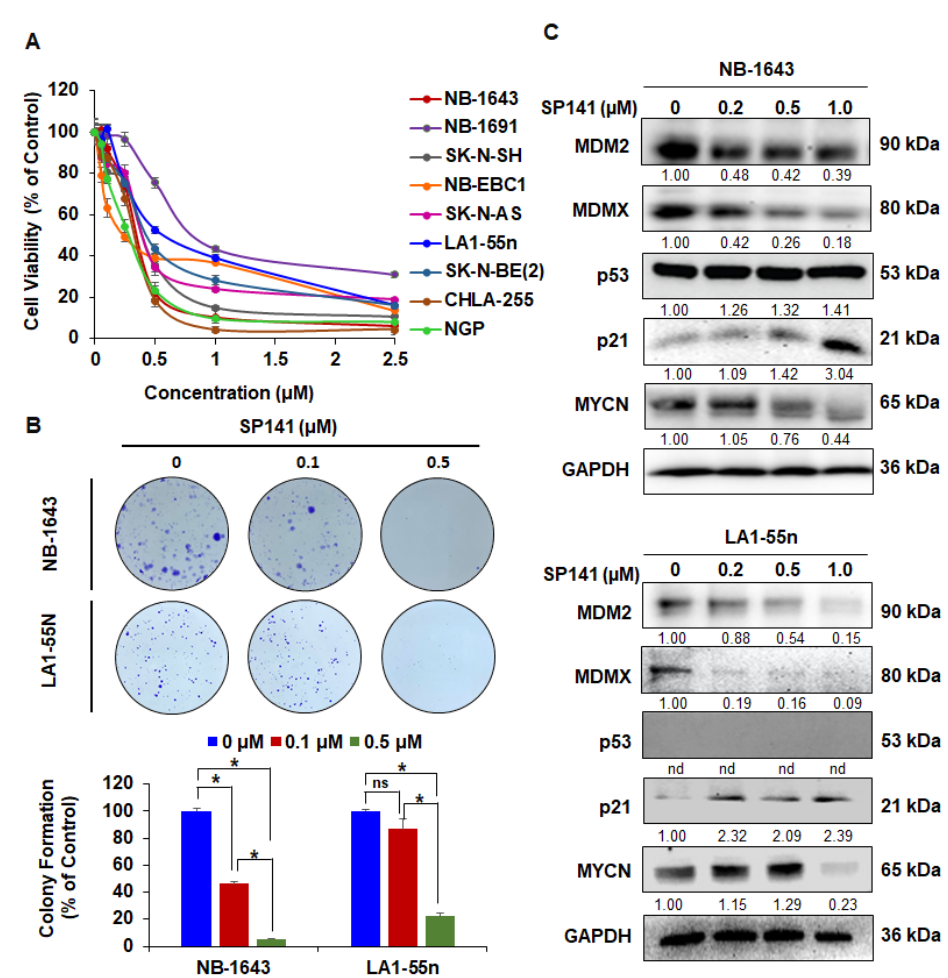
Figure 1. SP141 inhibits cell growth and reduces MDM2 protein levels in neuroblastoma cells, independent of p53. ( A ) SP141 inhibits the growth of neuroblastoma cells, independent of p53. The NB-1643 (p53 wild-type), SK-N-SH (p53 wild-type), NB-EBC1 (p53 wild-type), CHLA255 (p53